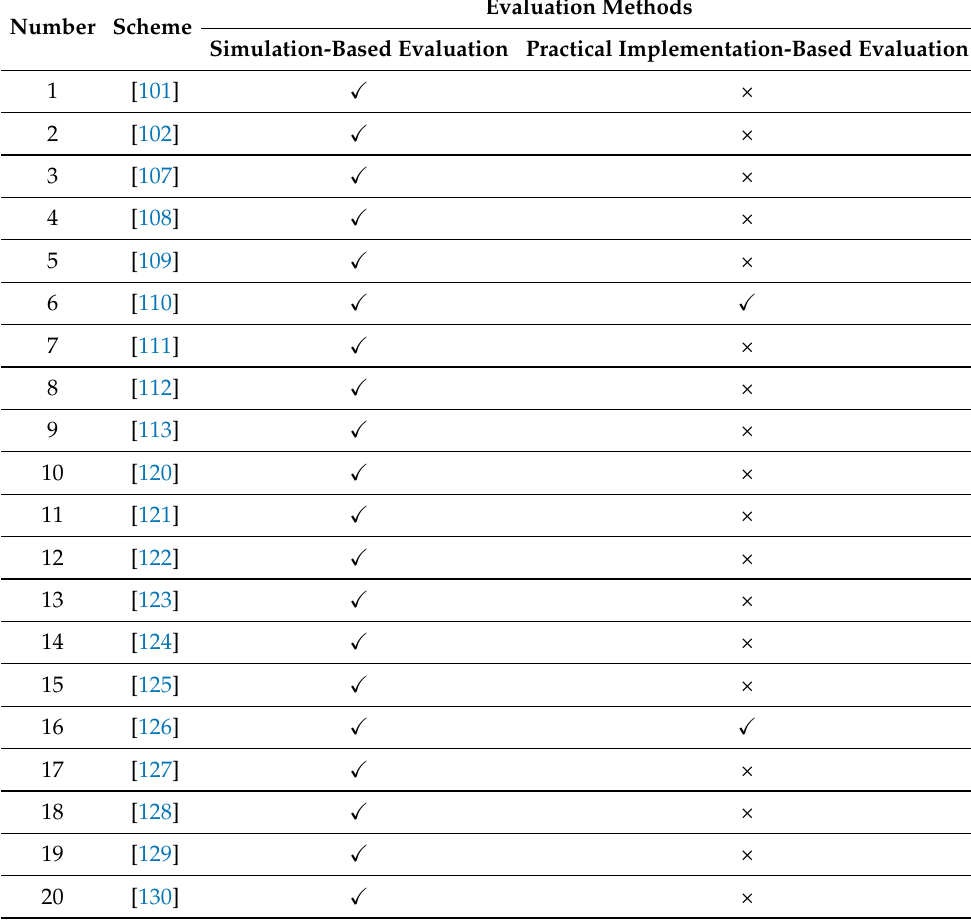
Table 18. Classification of ML-based methods in terms of evaluation methods. Number